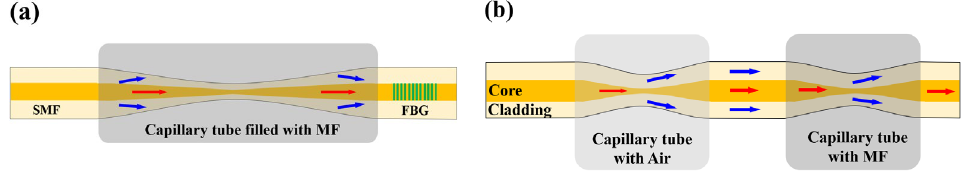
Figure 7. Magnetic field fiber sensors based on ( a ) NATMF (reprinted and adapted with permission from Ref. [52], 2022, IEEE) and ( b ) OVE [55].